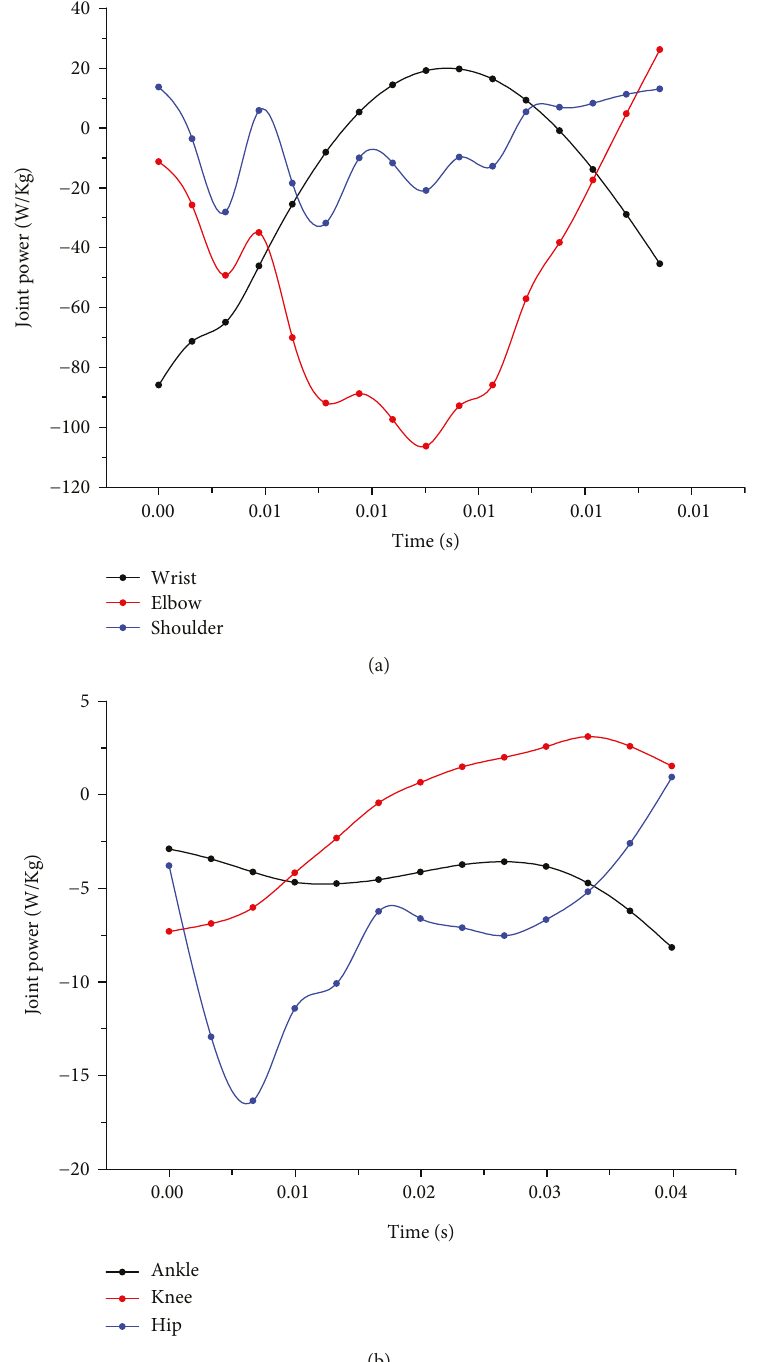
Figure 7: Joint power of (a) the RF wrist, elbow, and shoulder joints and (b) the RH ankle, knee, and hip joints during landing from a 1.2m